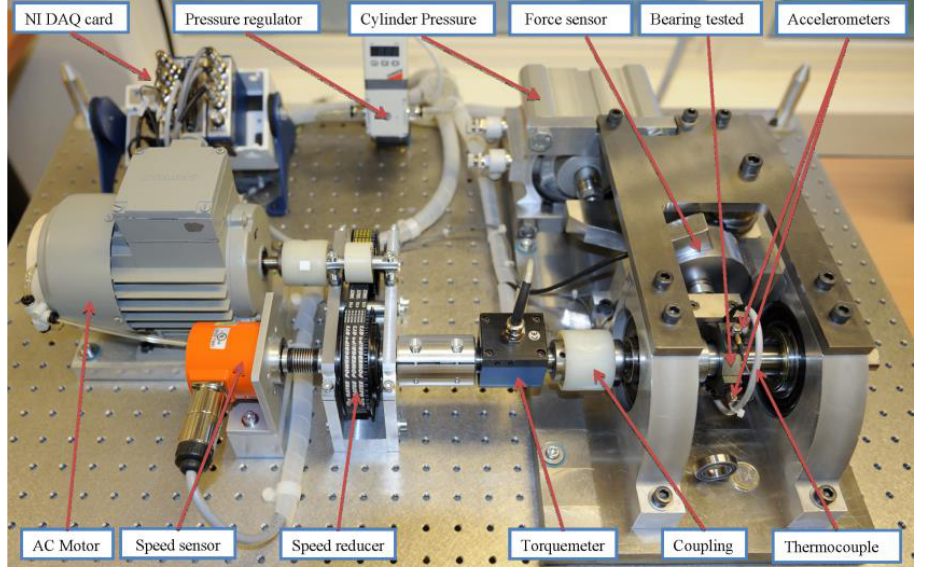
Figure 6. PRONOSTIA test bench. Table 1. Training set and test set